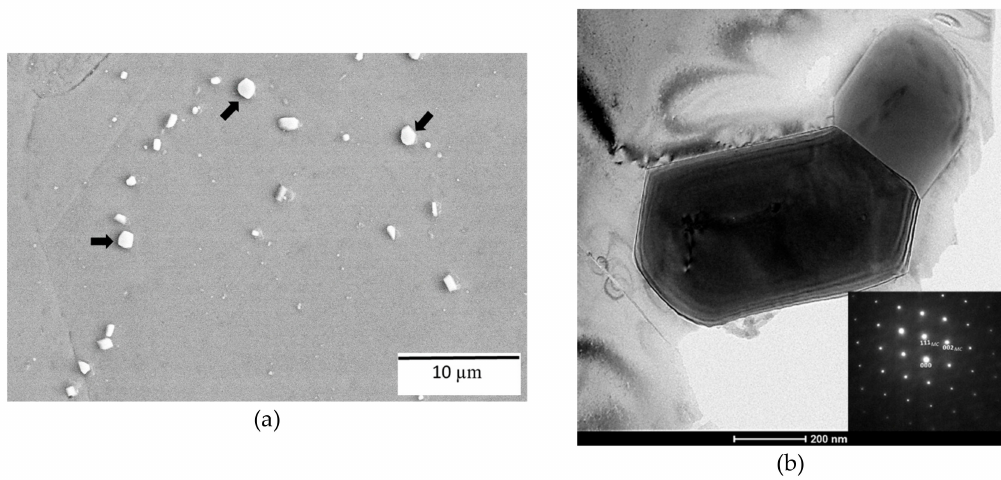
Figure 5. ( a ) Microstructure of HIP condition disclosing equiaxed grain structure and NbC carbides marked with arrows (electrolytically etched with oxalic acid), and ( b ) bright field image of carbide in HIP condition; the inset shows the di ff raction pattern of carbide.